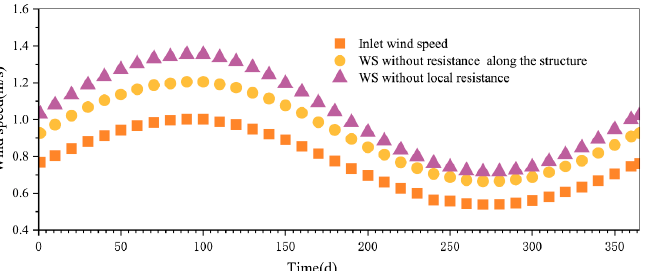
Figure 11. Annual variation of wind speed considering resistance loss along the pipe and local resistance loss.